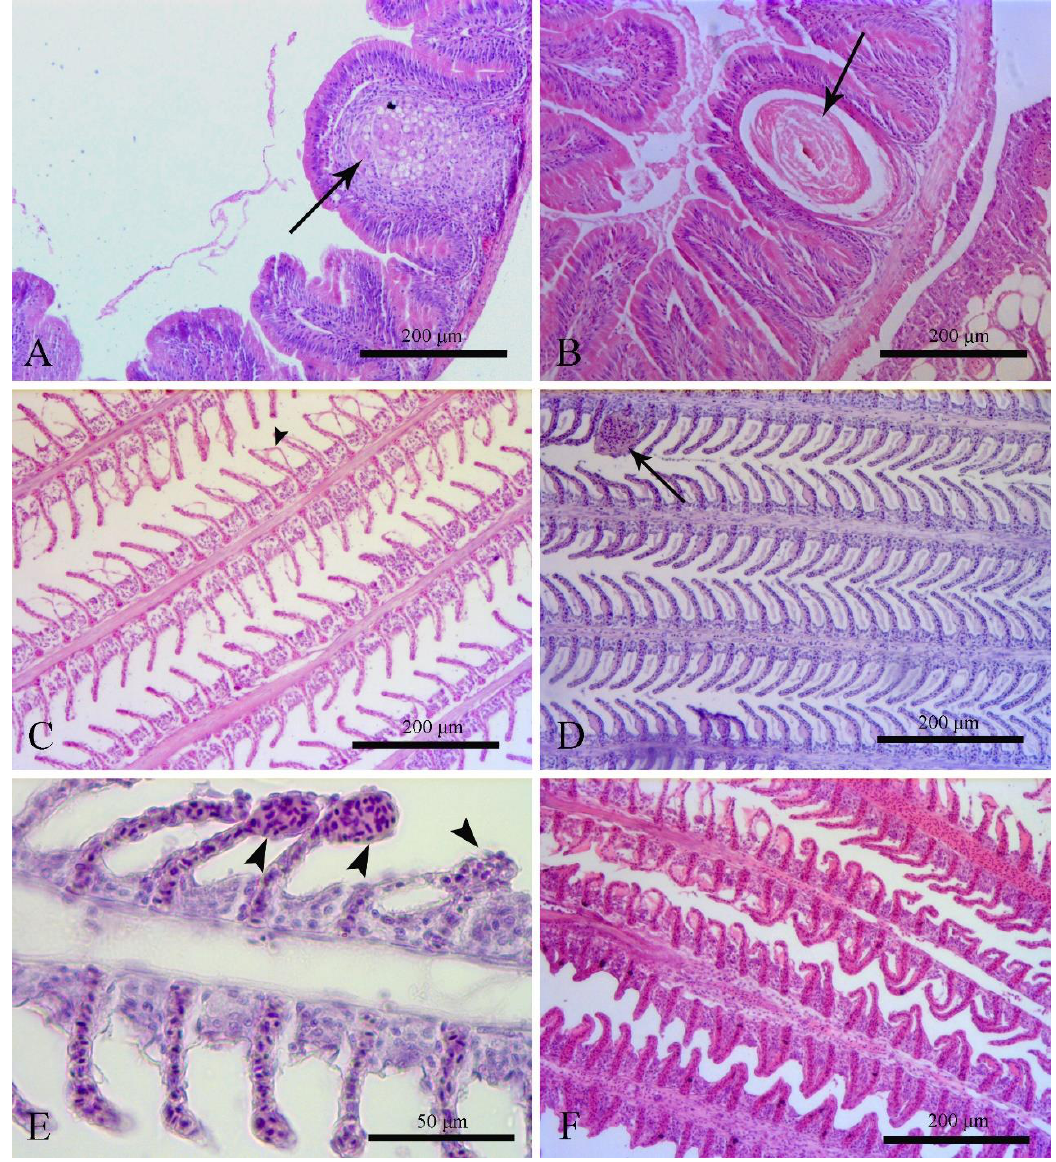
Figure 4. ( A ) Fe-group midgut. In one fish, an extremely large artery was observed to a midgut villi (arrow). ( B ) Fe-group midgut. In one fish, a region with an abnormal stretching of the lamina propria was detected (arrow). ( C ) Control group-gills. Epithelium detachment at the secondary lamella (arrowhead) is considered an artifact. ( D ) Fe-group gills. Hyperemia of secondary lamella (arrow). ( E ) Fe + K-group gills. Telangiectasia of secondary lamellae (arrowhead). ( F ) Fe + K-group gills. Hyperplasia of primary lamellae.